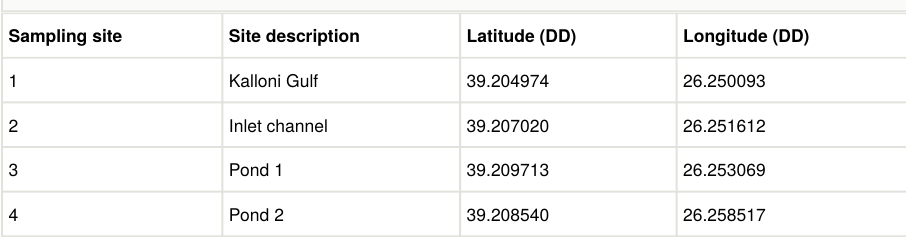
Geographic coordinates of the sampling